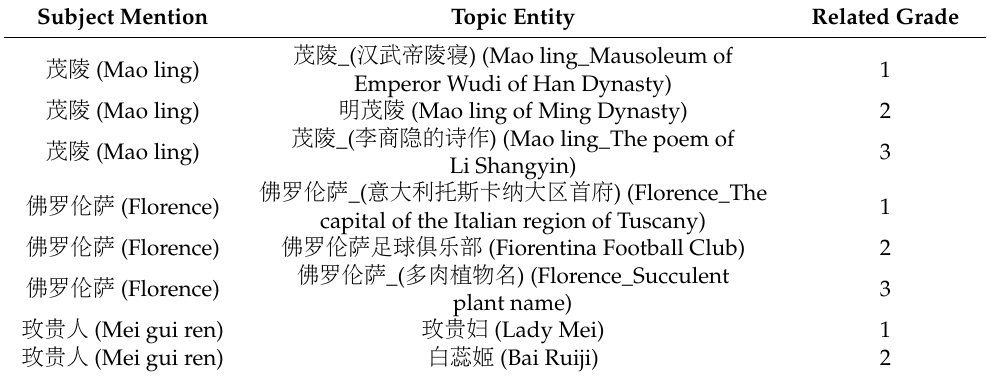
Table 1. An example of entity linking